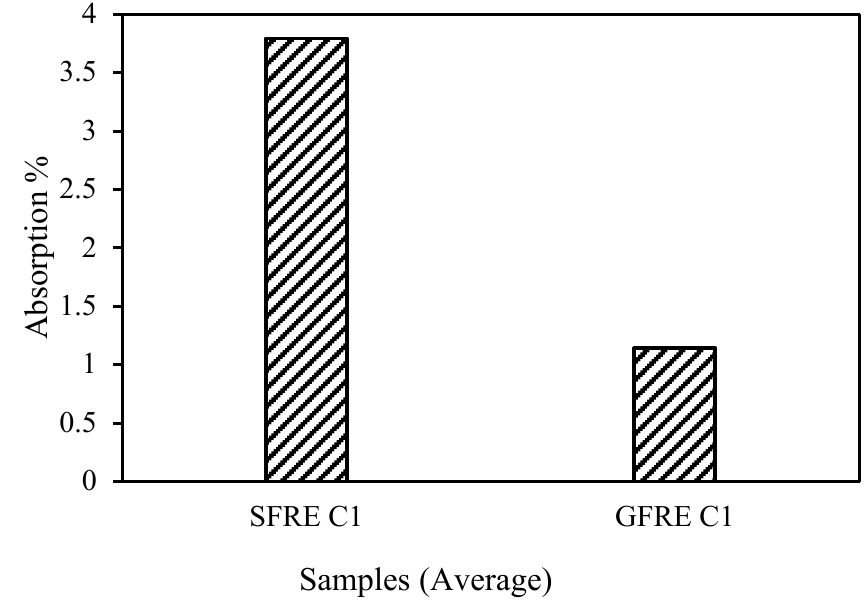
Figure 13. Preliminary study of the capability of sisal and glass fibres to absorb moisture at C1.